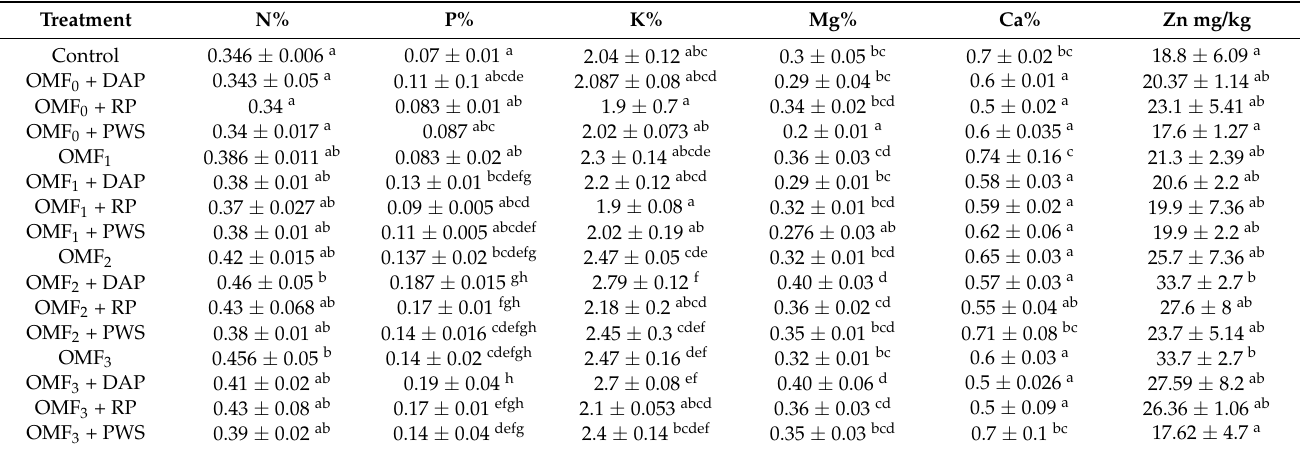
Table 5. Response of soil physicochemical properties after amendments and fertilization strategies for 3 months of harvesting